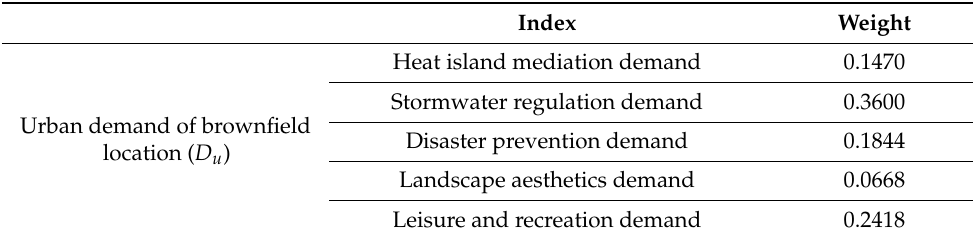
Table 6. Weights of urban functional demand